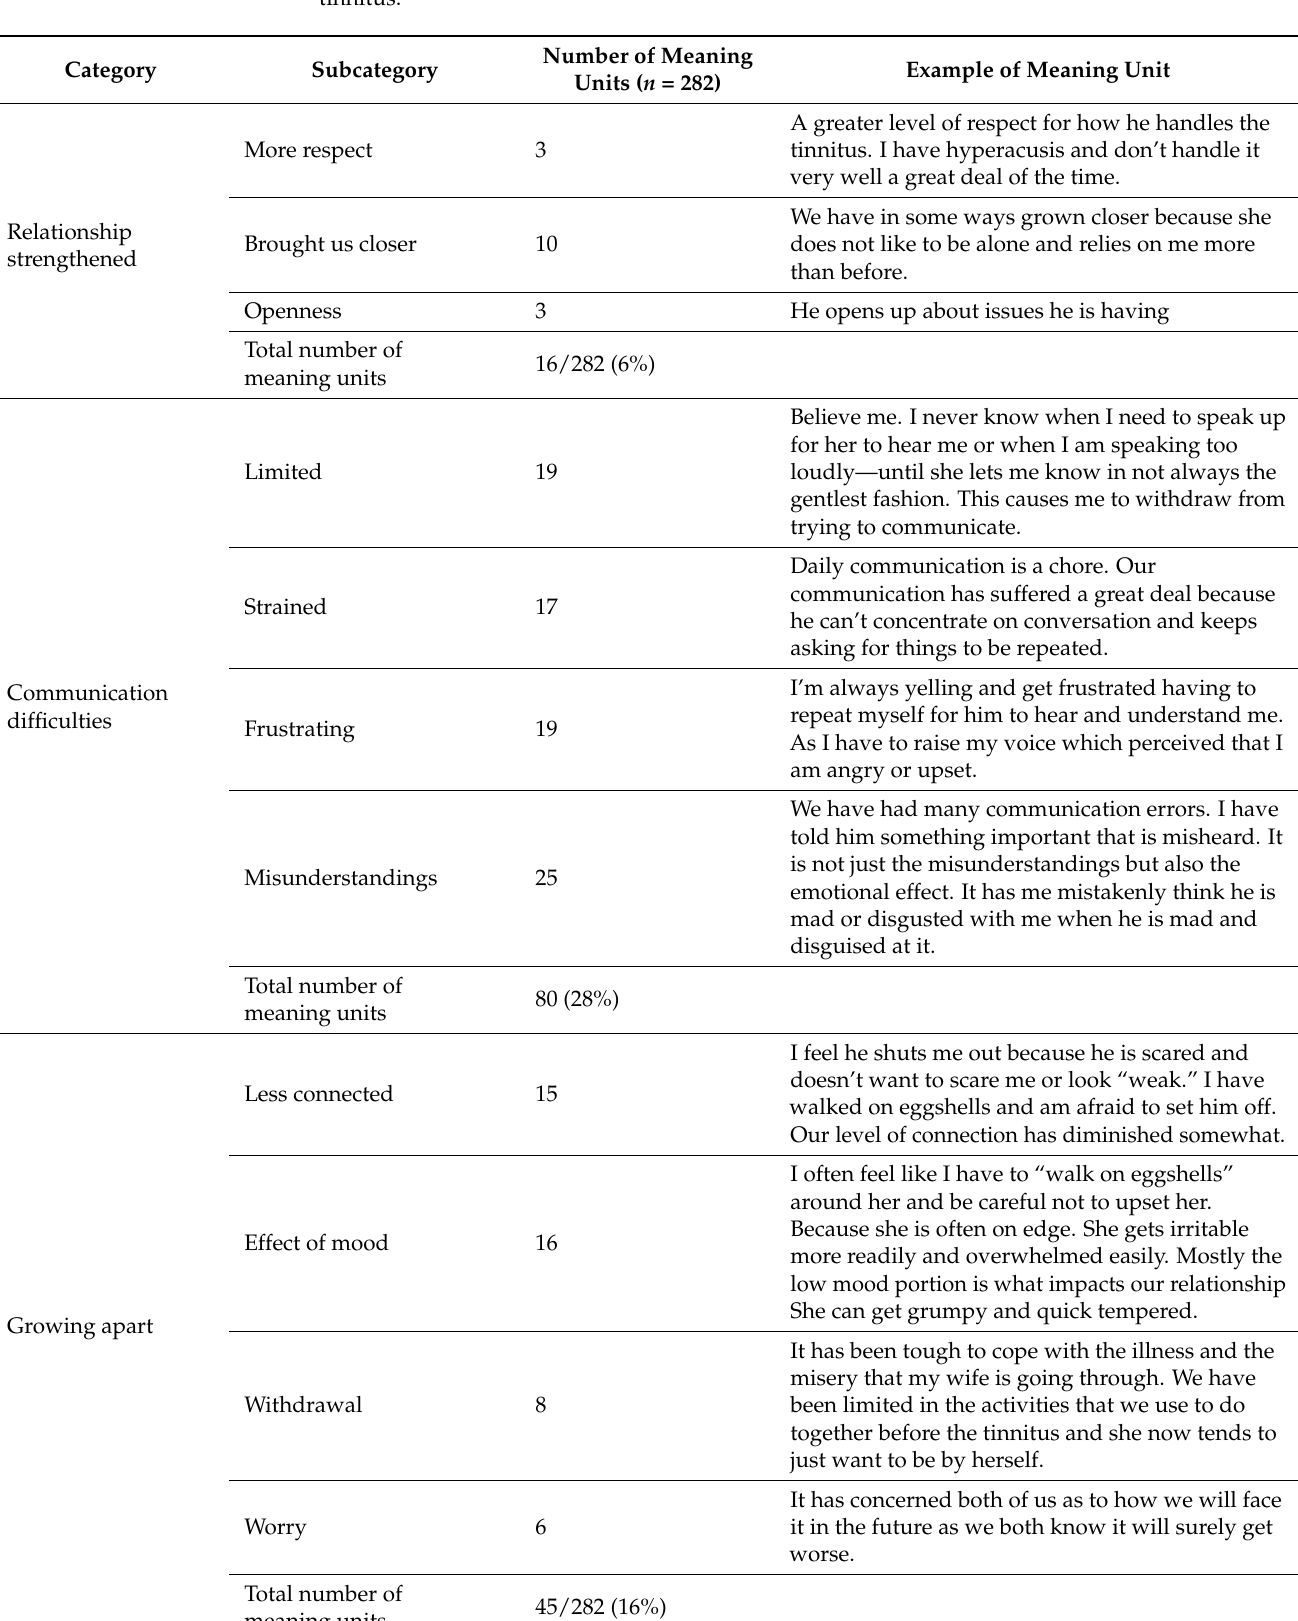
Table 4. Tinnitus effects on the relationship between significant others and the individual with